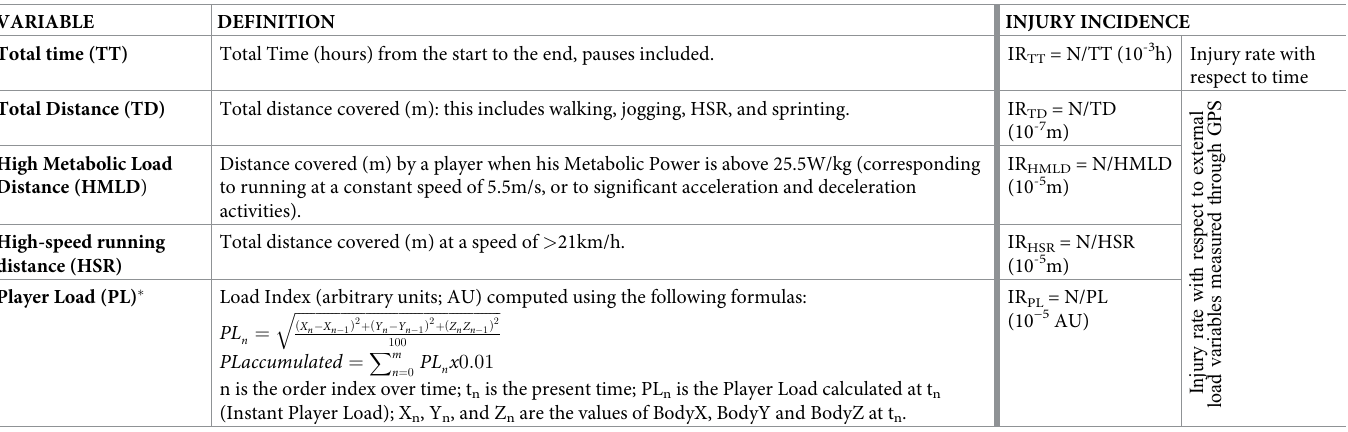
Table 1. Definition of external load